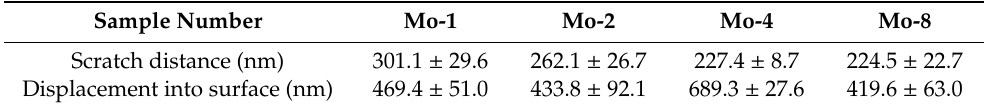
Table 2. The average scratch distance and displacement into the surface of five scratch tracks on the Si / Mo / Ti multilayer film surface where the Mo / Ti film started to delaminate from the Si substrate. The standard deviation was statistically calculated from the five scratch tracks for each sample.